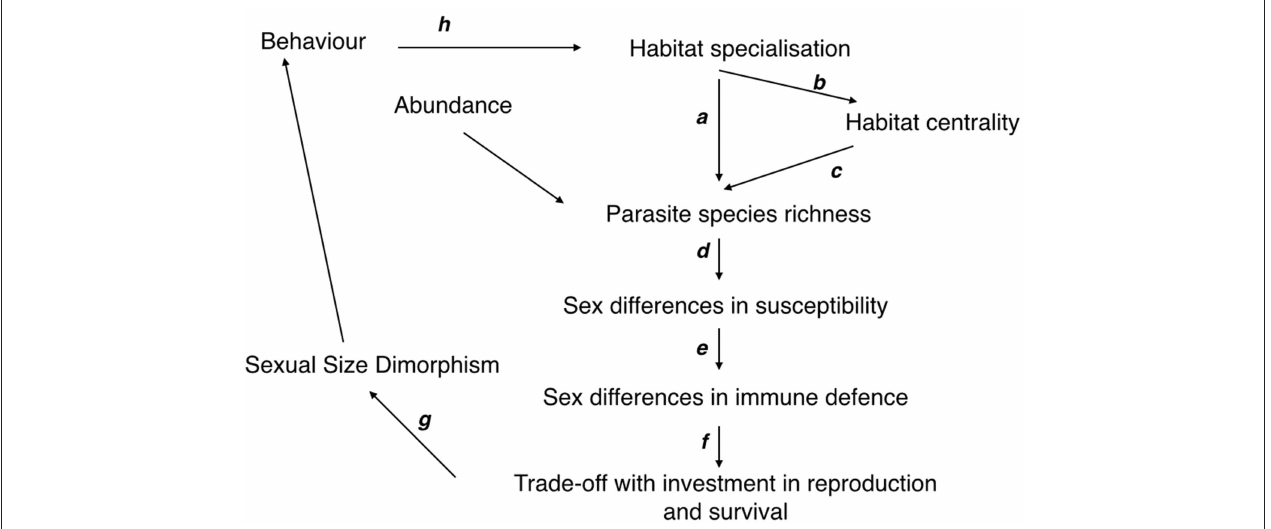
FIGURE 1 | Causal chain of relationships linking habitat specialization, parasite diversity, life-traits and sexual size dimorphism (see